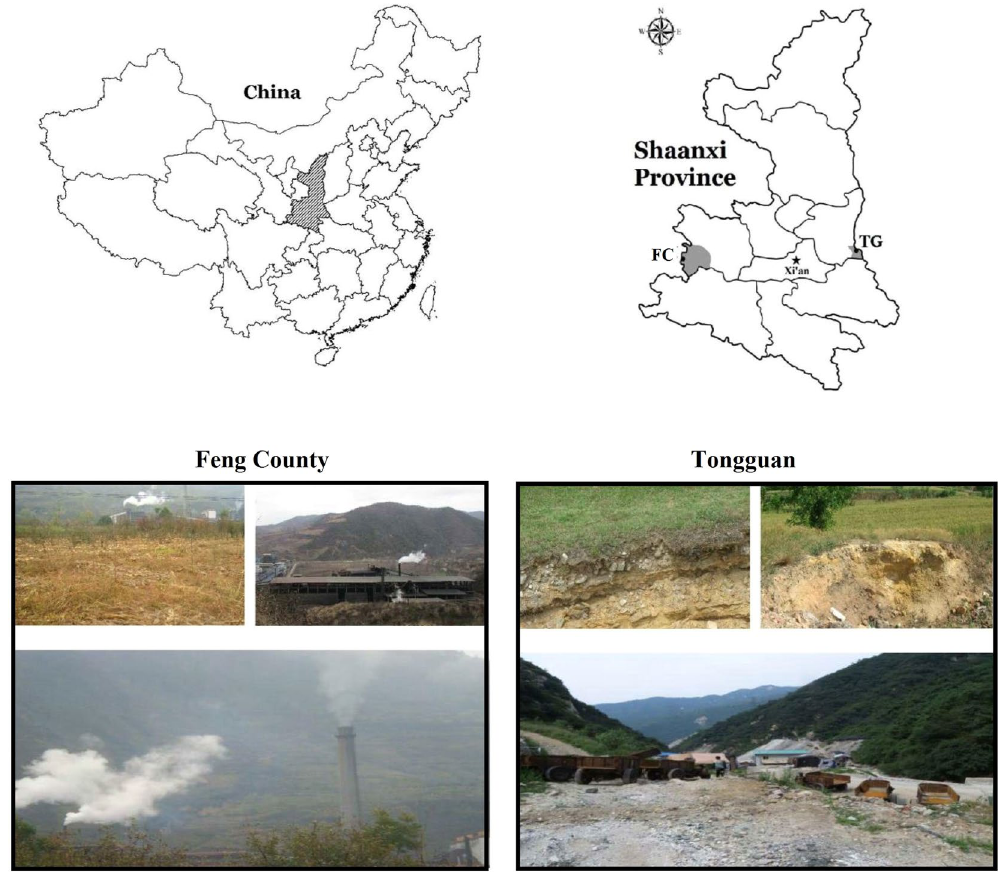
Figure 9. Sampling sites in Feng County and Tongguan, Shaanxi province, China. The map was adopted from Shen, et al . 42 with permission. The maps were created using ESRI’s ArcGIS 9.0 software (http://www.esri.com/